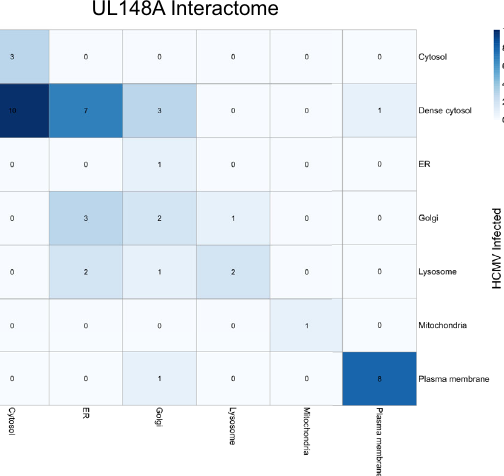
from BANDLE where each entry of the heatmap is the number of proteins. Off- diagonal entries only include con fi dent differential localisations with probability >0.999. c UL148A interactome mapped onto the BANDLE determined spatial pat- terns.SourcedataareprovidedasaSourcedata fi